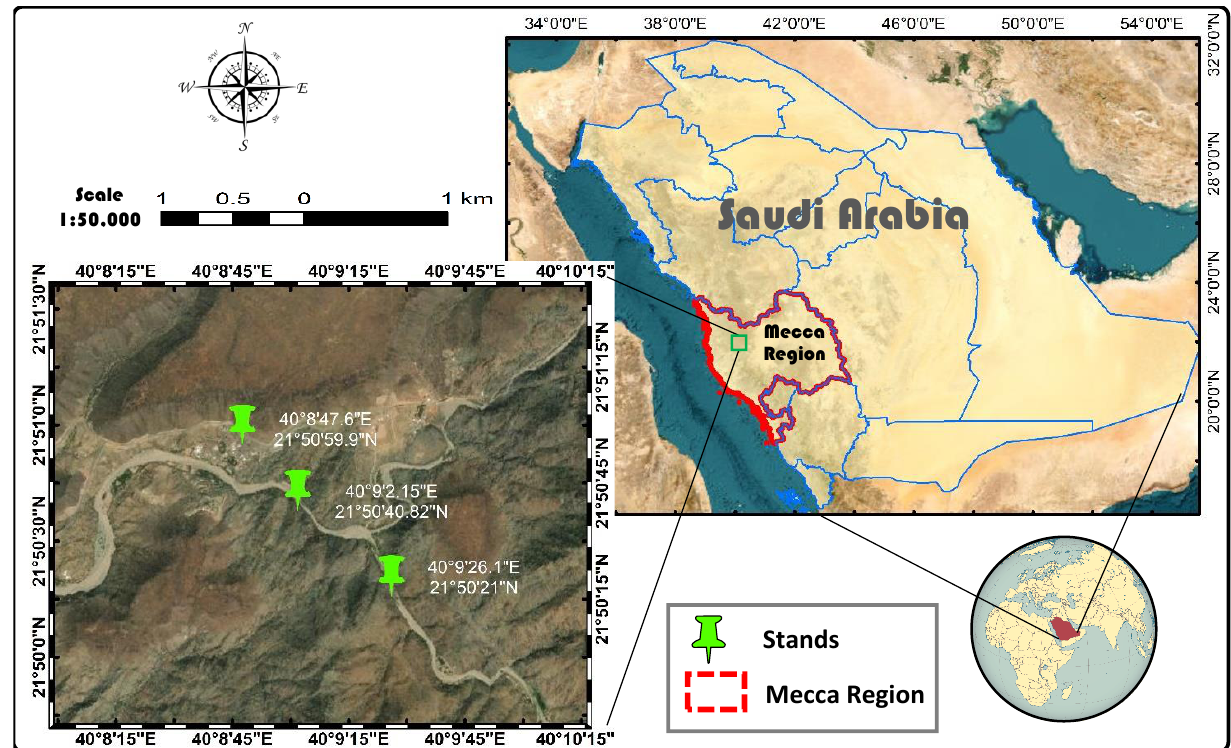
Figure 1. Map and information of the collected samples’ locations.